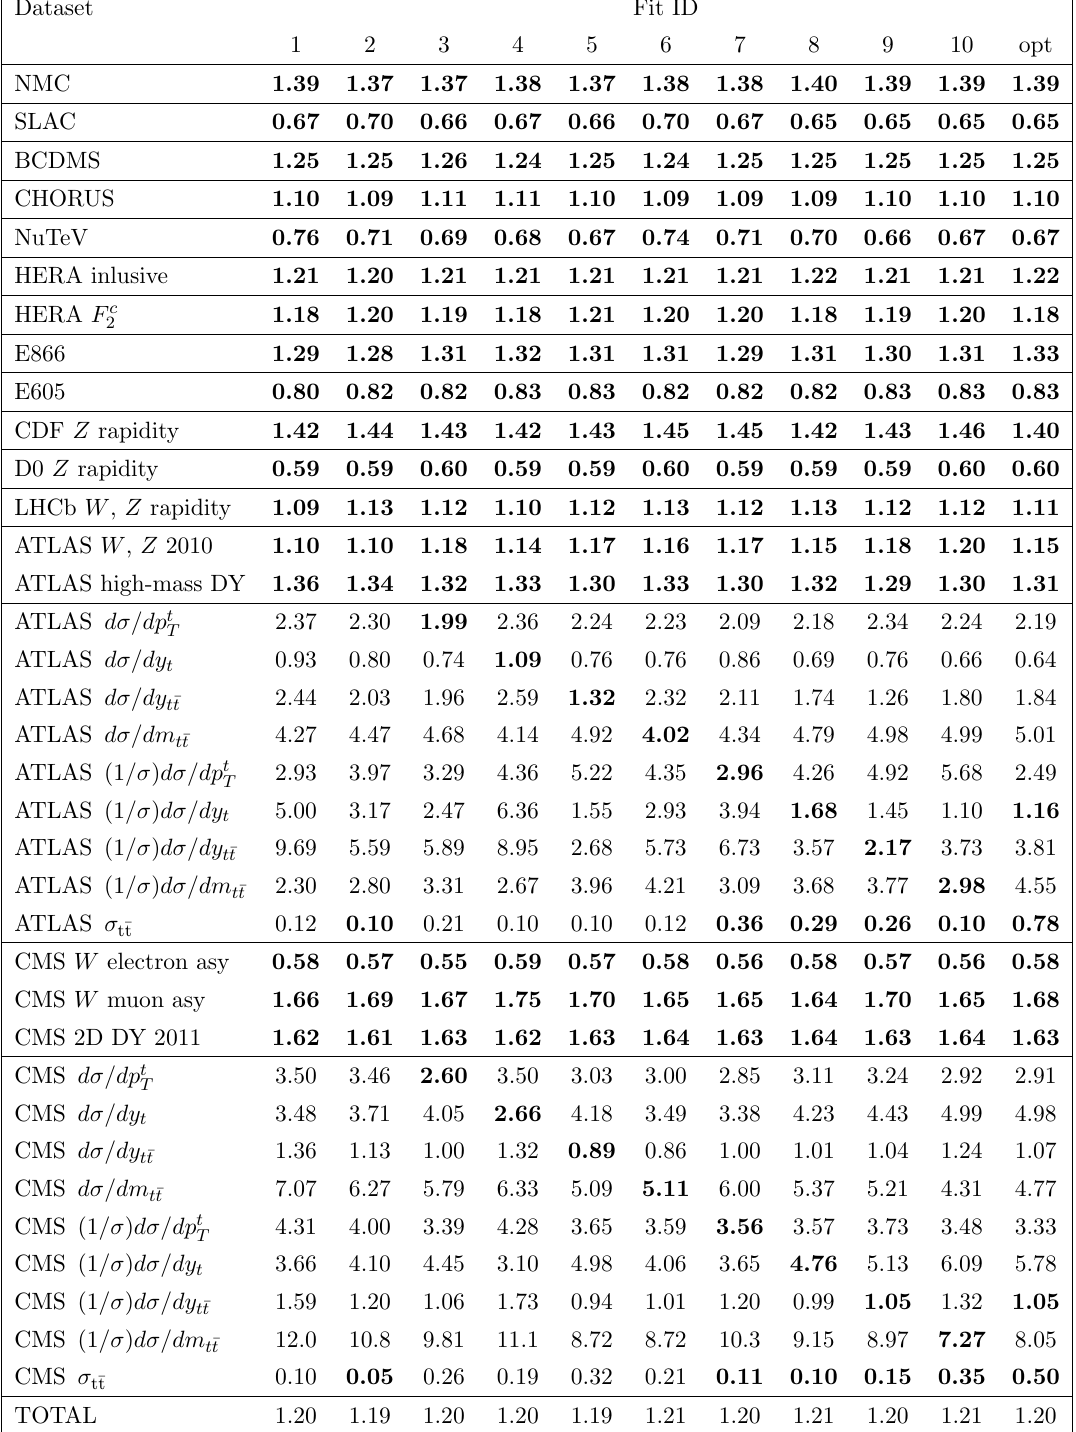
Table 7 . Same as table 6 for the global (cid:12)ts, including (last column) our optimal (cid:12)t to the optimal combination of top-quark pair di(cid:11)erential